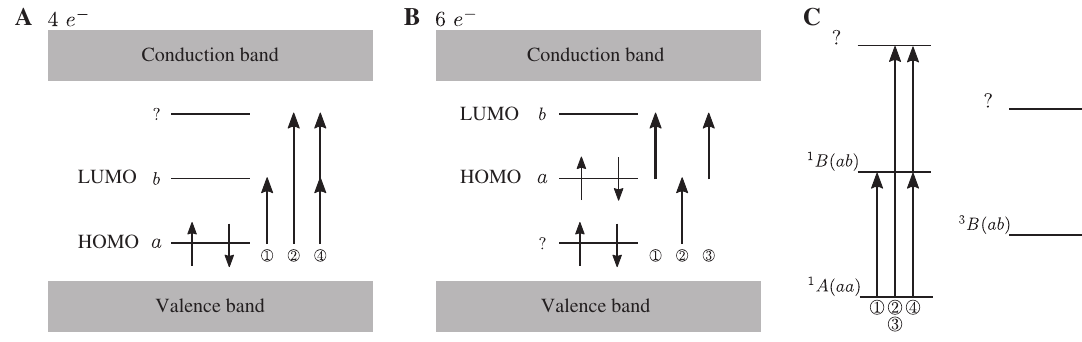
Figure 9: Systematics of the candidate electronic structures of the ST1 center. For an arbitrary HOMO/LUMO pair ( a , b ), (A) and (B) are the potential orbital configurations associated to the four- and six-electron molecular models, and (C) is the associated electronic structure if there was an internal manifold. The numbered arrows represent the allowed transition pathways to the first and second excited transitions. These, when combined with the orientation of the dipole moment, help identify the symmetry of the electronic